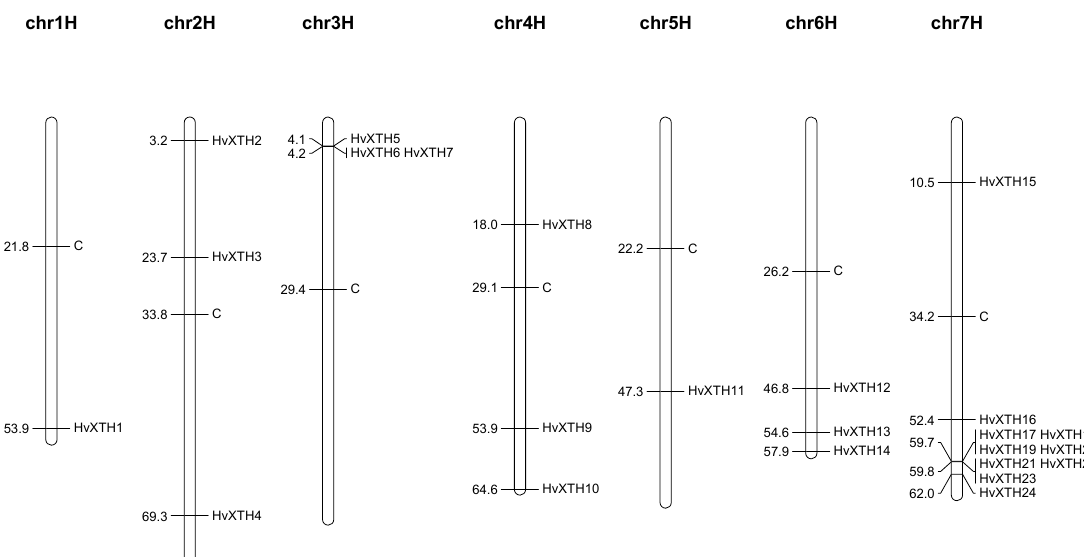
Figure 3. Distribution of HvXTH genes in barley chromosomes. The location of HvXTH gene family members in the genome barley cultivar ‘Morex’. C indicates the centromere.